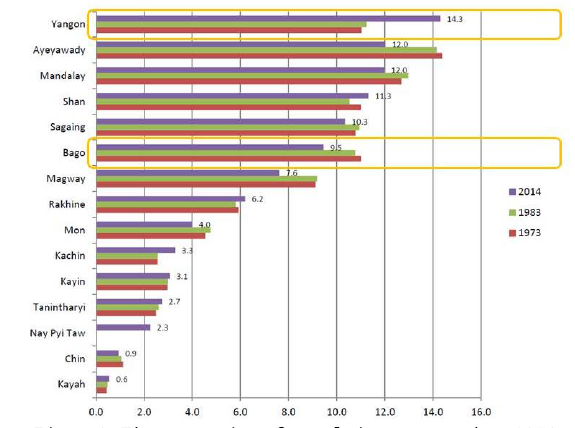
Figure 3: The proportion of population compared on 1973, 1983 and 2014 census data (Myanmar census, 2014a)